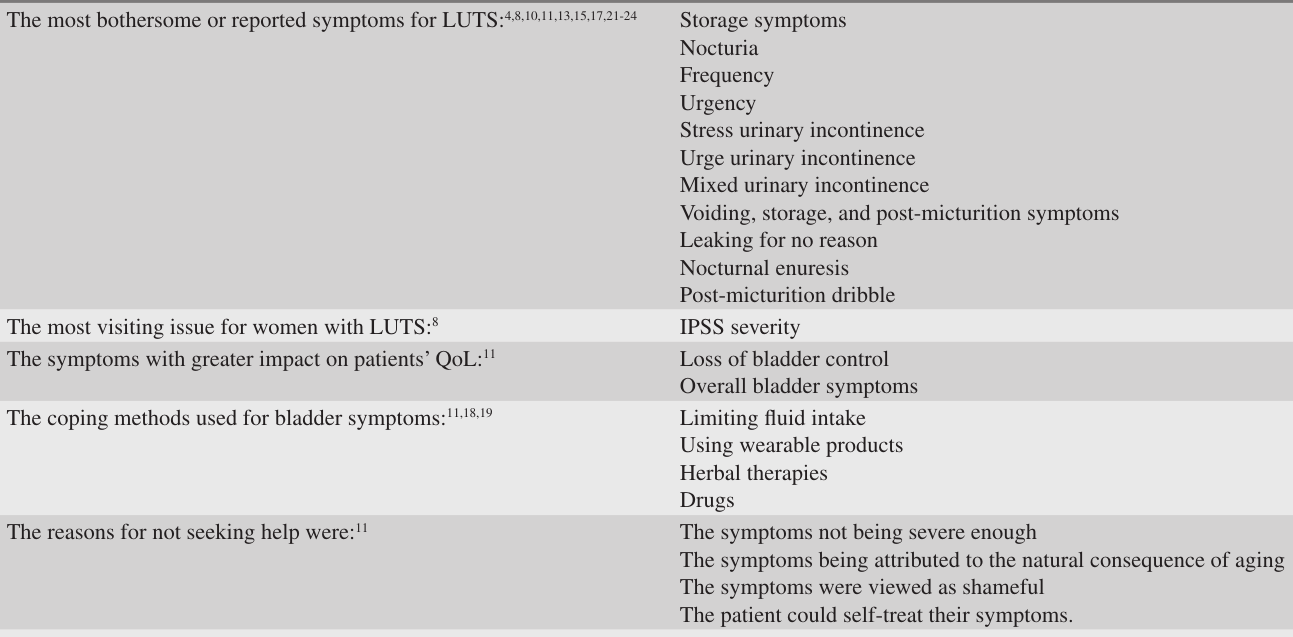
Table 7. The Most Bothersome Symptoms and Healthcare-Seeking Behaviors The most bothersome or reported symptoms for LUTS: